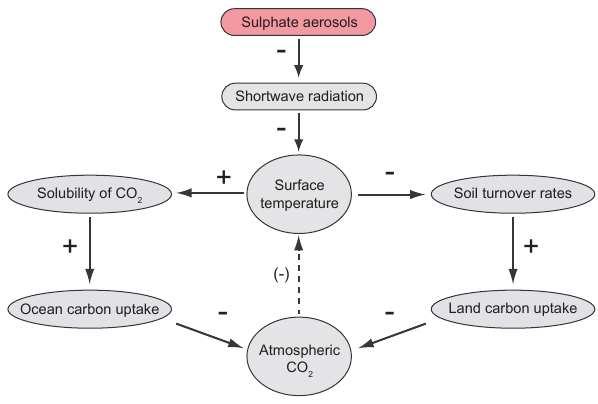
Fig. 14. Flowchart of changes after an explosive volcanic erup- tion. The small impact of enhanced mixing and export production, and decreased stratification on air-sea gas exchange as well as the impact of precipitation and diffuse radiation on NPP are neglected here. The dashed arrow shows the small amplifying feedback for climate